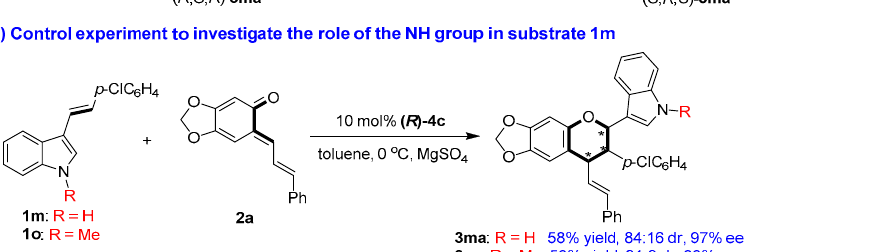
Figure 6. The asterisk * indicates chiral center. Figure 6. Calculated transition states leading to the enantiomers of 3ma and control experiment. The asterisk * indicates chiral